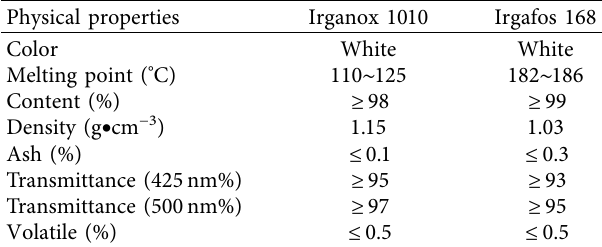
Table 2: The common indexes of